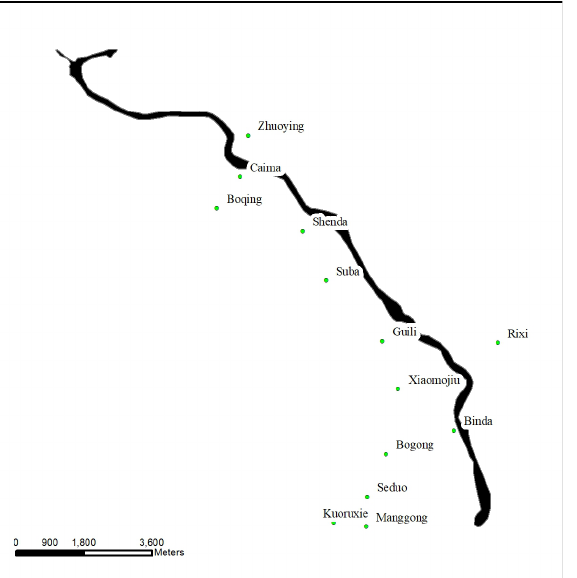
Figure 7. Water extraction result from Sentinel-1A image